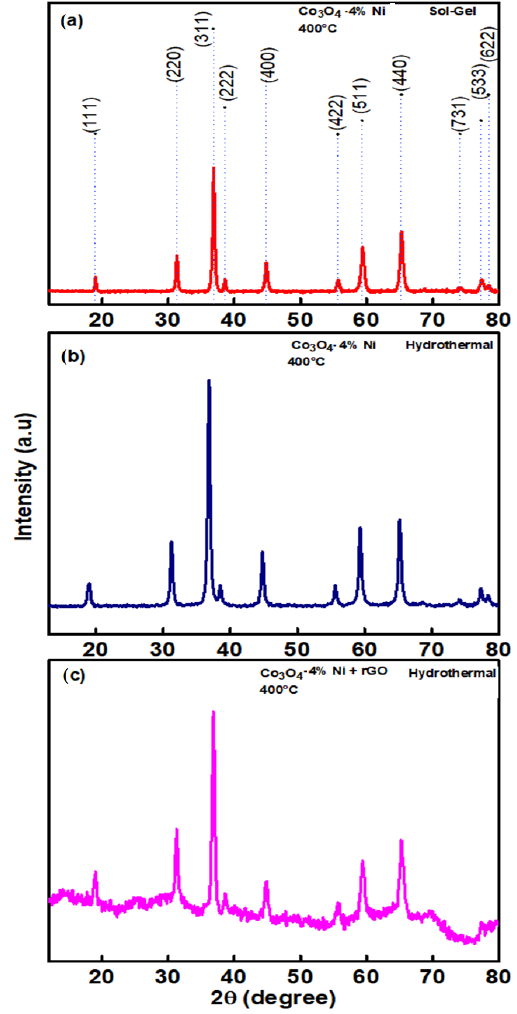
Figure 2. Powder X-ray patterns of Co 3 O 4 phase nanocrystals at 400 ° C and 4% Ni: ( a ) Co 3 O 4